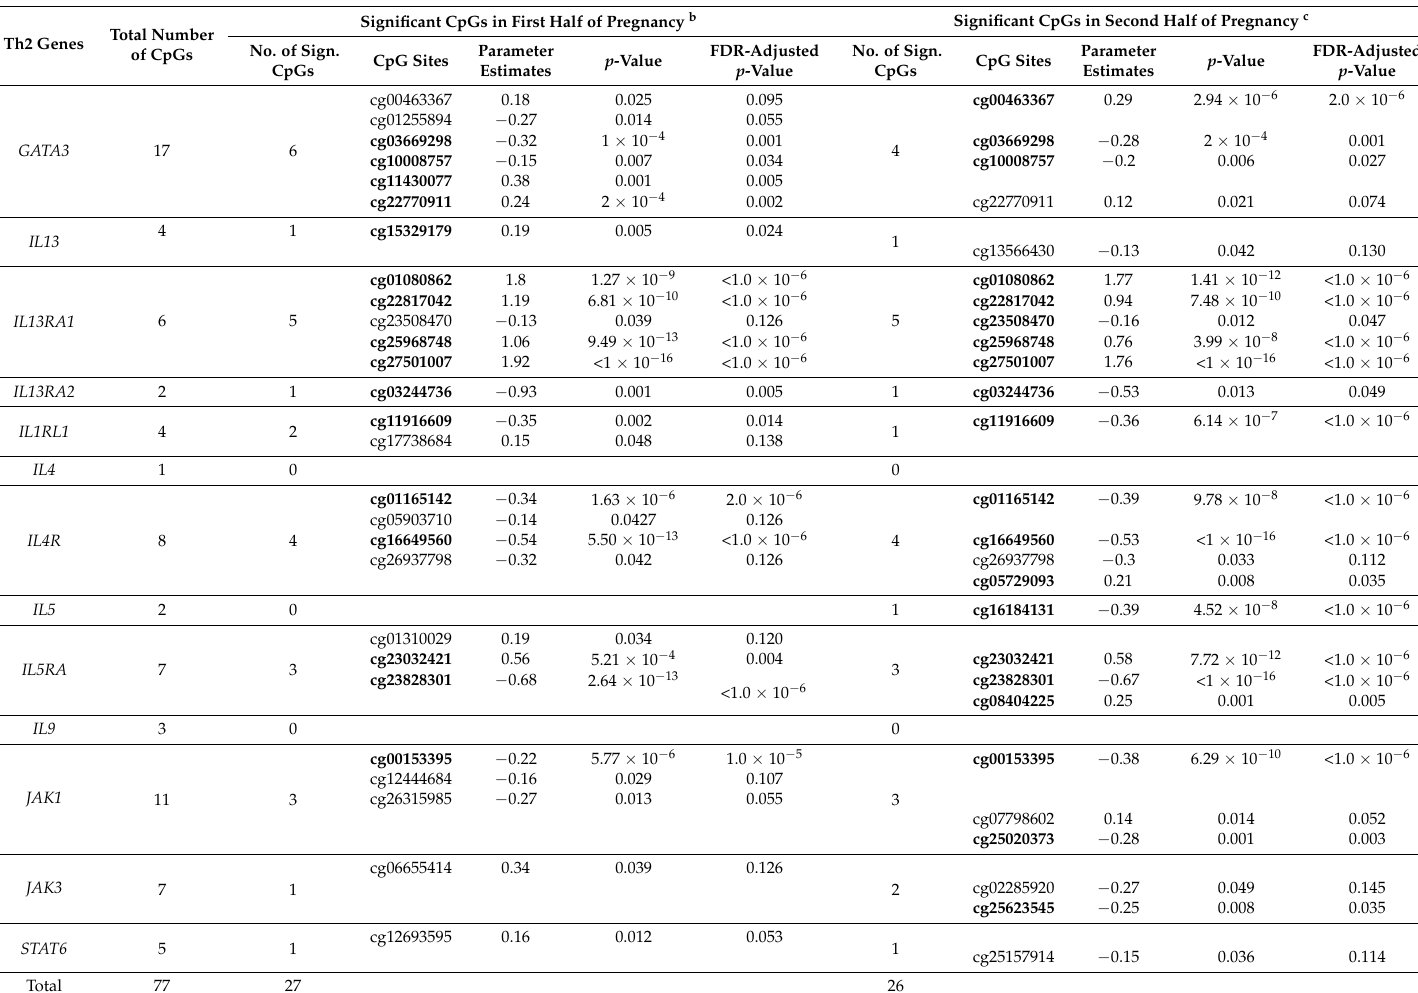
Table 3. Th2 CpGs showing statistically significant changes ( p ≤ 0.05) during first and second halves of pregnancy a